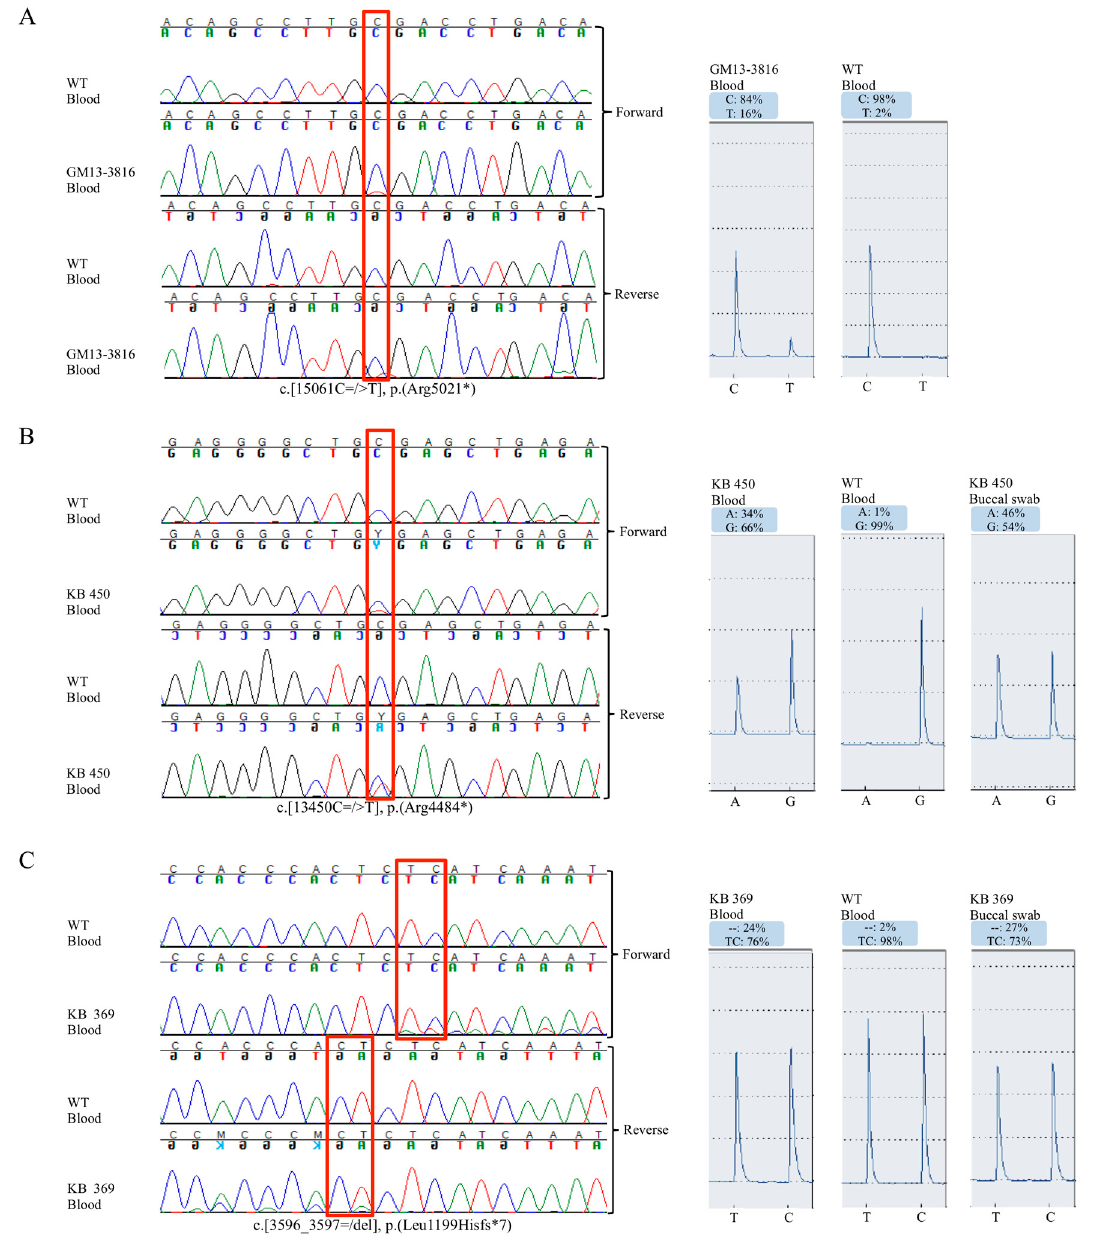
Figure 2. Pyrosequencing analysis confirmed the mosaic mutations. ( A – C ) On the left, blood DNA Sanger sequencing electropherogram of indicated patients and healthy controls. Red frame indicates the mosaic nucleotide variants. On the right, pyrosequencing peak profile of patients and control with percentage quantification of mosaic nucleotide variants. Note that for KB 450 the reverse sequence is reported for Pyrosequencing.